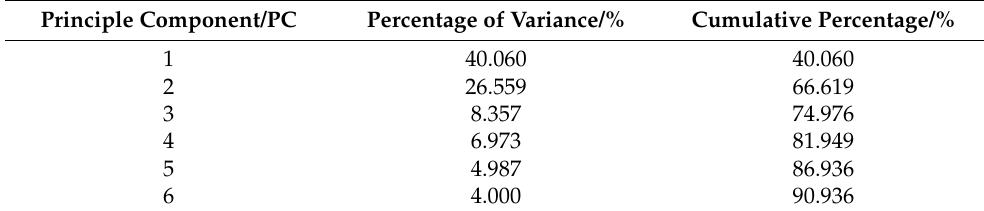
Table 2. Variance contribution percentage for PCs from